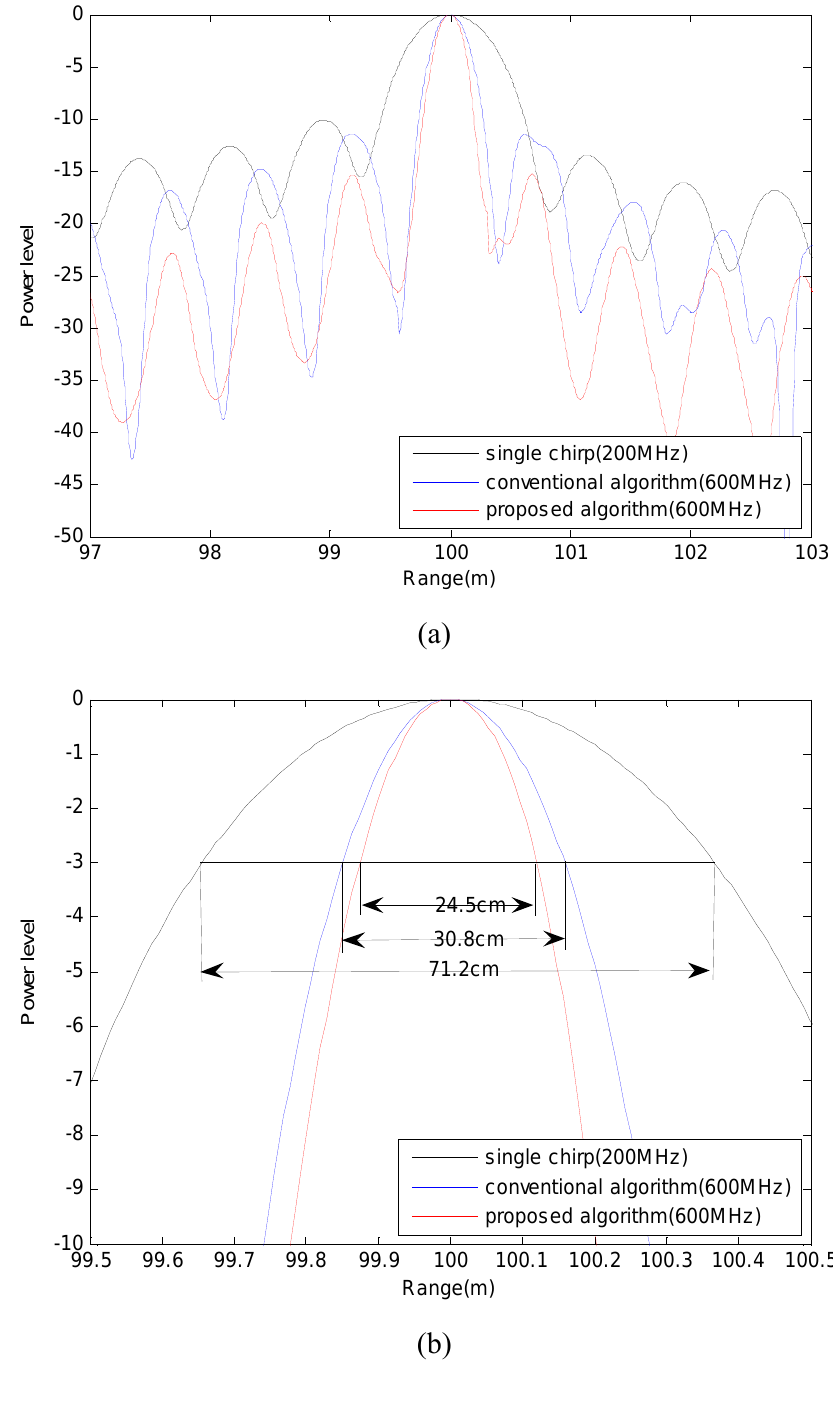
Figure 4. Simulation and experimental results for a point target. (a) Range profiles using simulation, (b) mainlobe comparison of simulated data, (c) measured range profiles, (d) measured azimuth